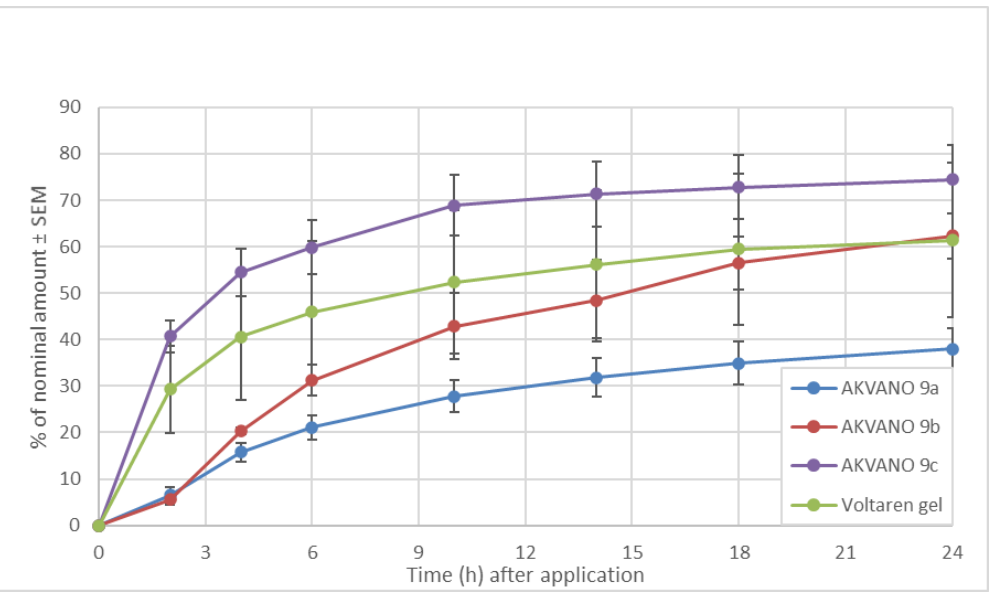
Figure 10. Cumulative permeation of diclofenac diethylamine through Strat-M membranes.